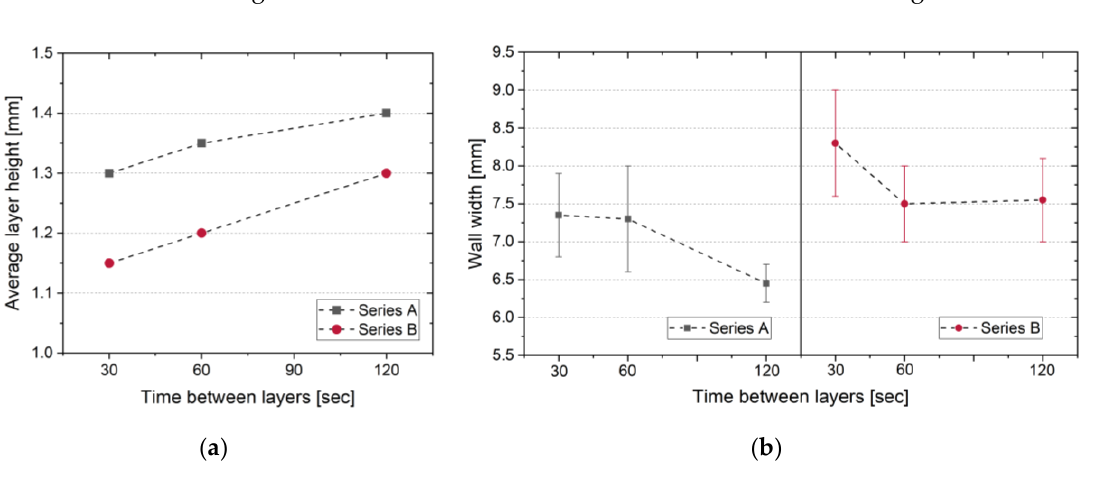
Figure 6. Effect of building strategy on average layer height ( a ) and wall width ( b ). Figure 6. E ff ect of building strategy on average layer height ( a ) and wall width ( b ).